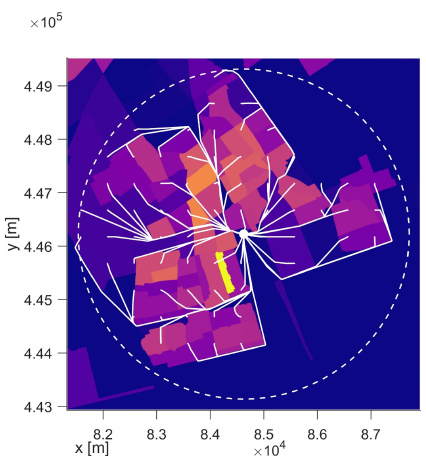
Figure A1. Histogram of CGRfh with different risk weight ratios.